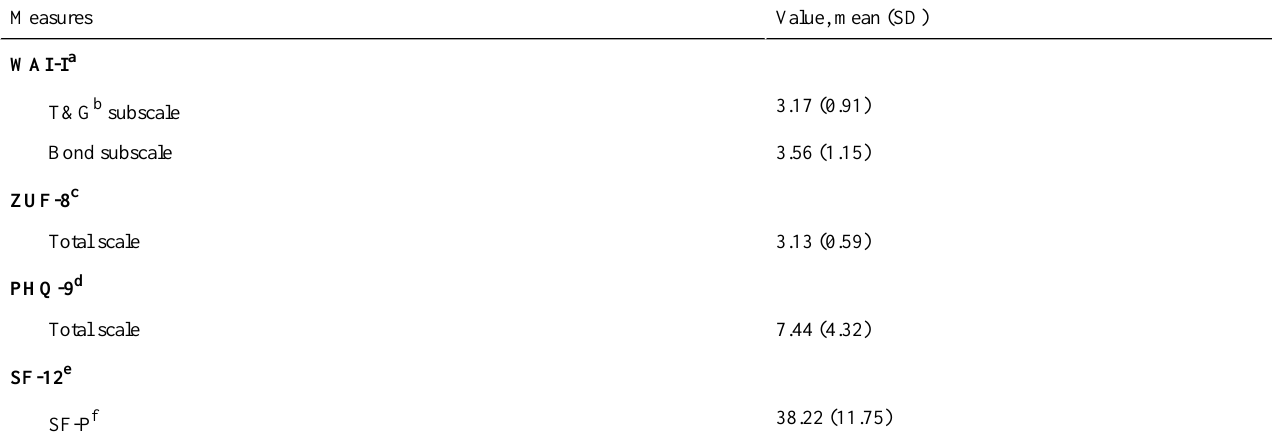
Table 1. Sample details at posttreatment for the variables in the